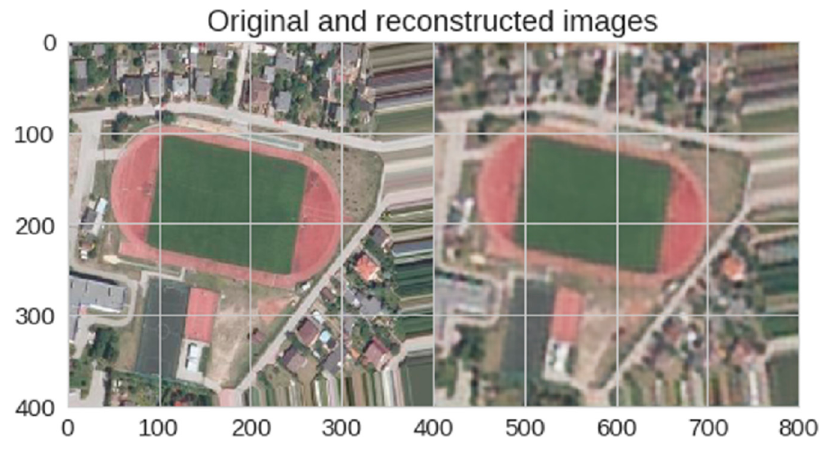
Figure 1. The input and output of a deep learning autoencoder (DLA).